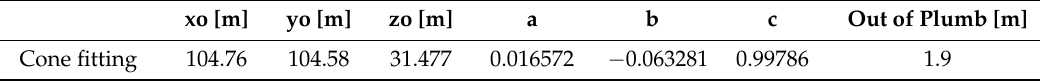
Figure 17. Nonlinear least squares cone fitting parameters converged to optimal. Table 4. Cone fitting parameters of the whole point cloud of al Hadbaa minaret.